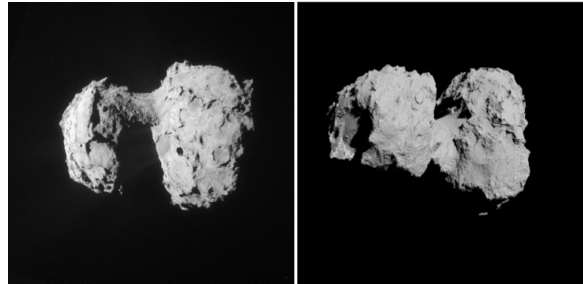
Figure 8. Real Image ( left ). Simulated Image ( right